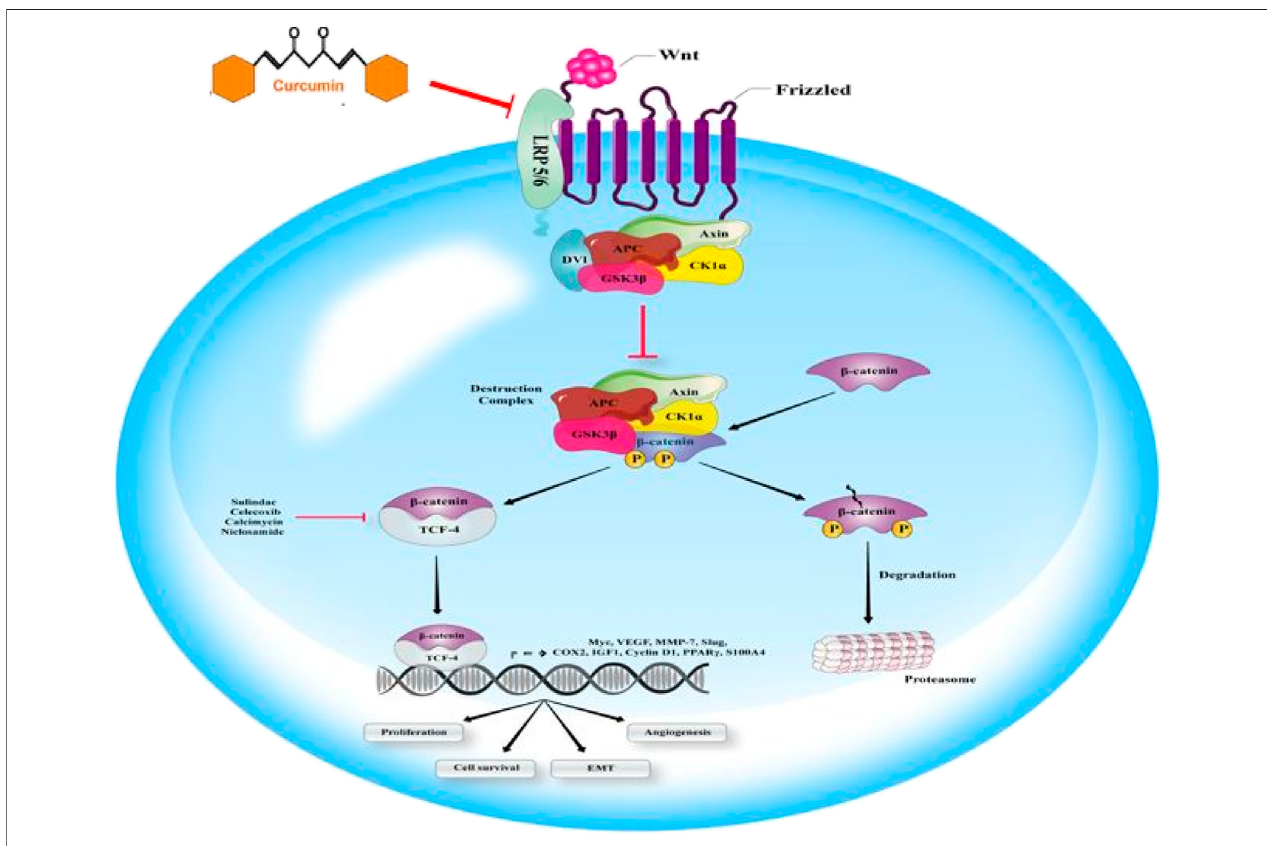
FIGURE 5 | Wnt signaling can affect the cascade of metastasis. Wnt ligand binding to the multipass receptor leads to inhibiting demolition complex and the nucleic accumulation of β -catenin, involved in Wnt gene expression. Some of the antibiotic calcimycin, NSAIDs such as celecoxib or sulindac, and the anthelminthic niclosamide play a signi fi cant role in β -catenin-induced gene transcription targeting. Curumin is able to inhibit Wnt signaling.